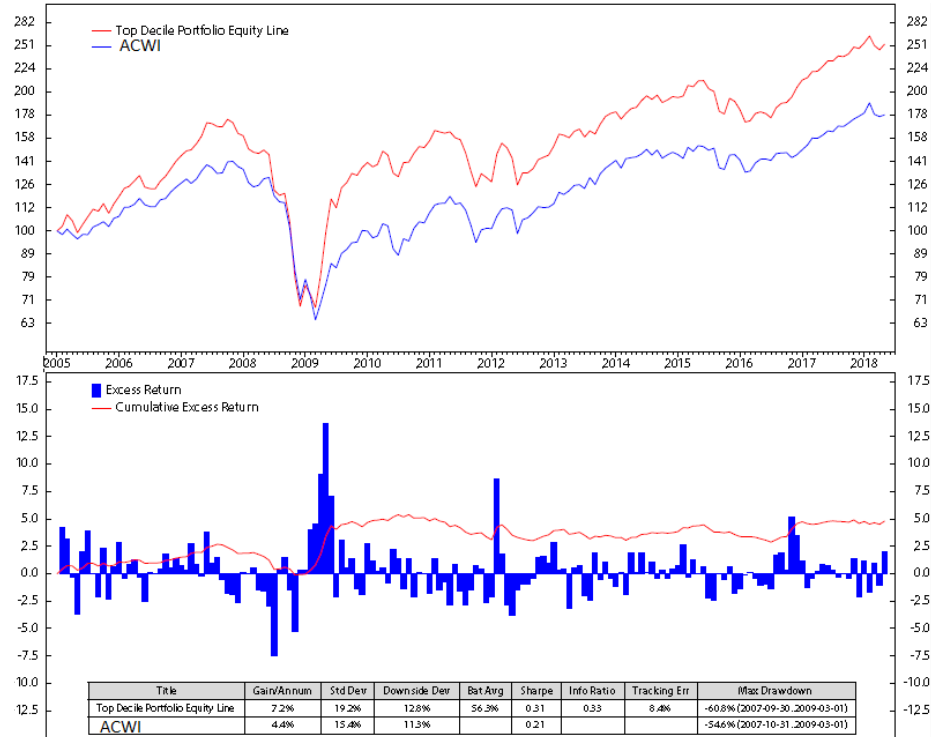
Figure A7. Global stock selection from January 2005 to September 2017 based on stock earning/price factor.